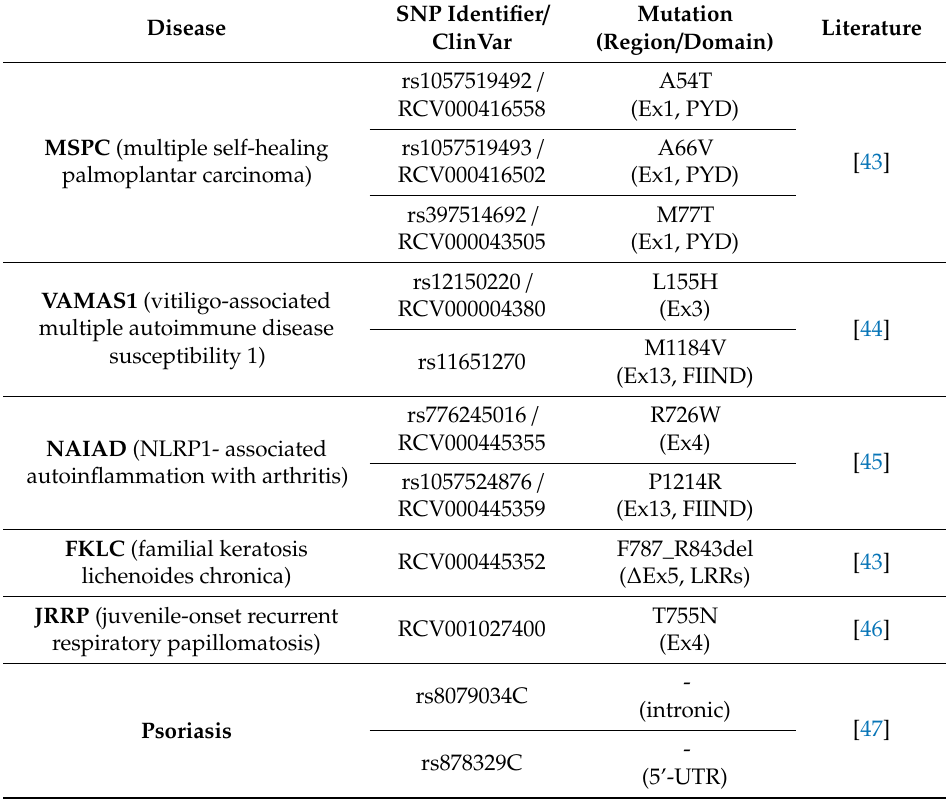
Table 1. Selected NLRP1 mutations in human disease with skin